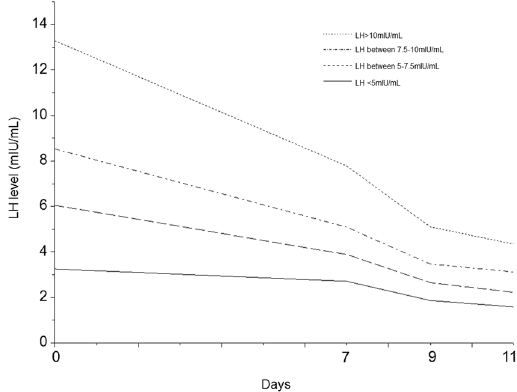
Figure 1. Median serum LH levels in the patients on stimulation days 0, 7, 9, and 11. The differences in serum LH among the four groups are significant on days 0, 7, 9, and 11 (P < 0.001). Group with LH < 5 mIU/mL: solid line; group with LH between 5 and 7.5 mIU/mL: dashed line; group with LH between 7.5 and 10 mIU/mL: dashed-dotted line; group with LH ≥ 10 mIU/mL: dotted line.